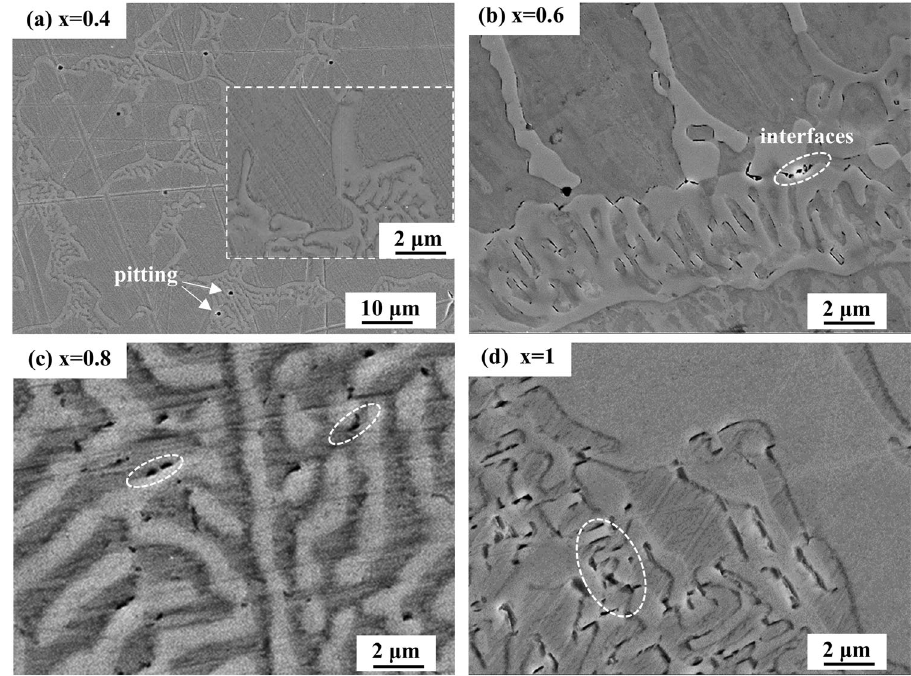
Fig. 8 SEM images after the potentiostatic polarization. SEM images of ( a ) Mo 0.4 , ( b ) Mo 0.6 , ( c ) Mo 0.8 , ( d ) Mo 1 after the potentiostatic polarization at 0.4 V SCE for 10